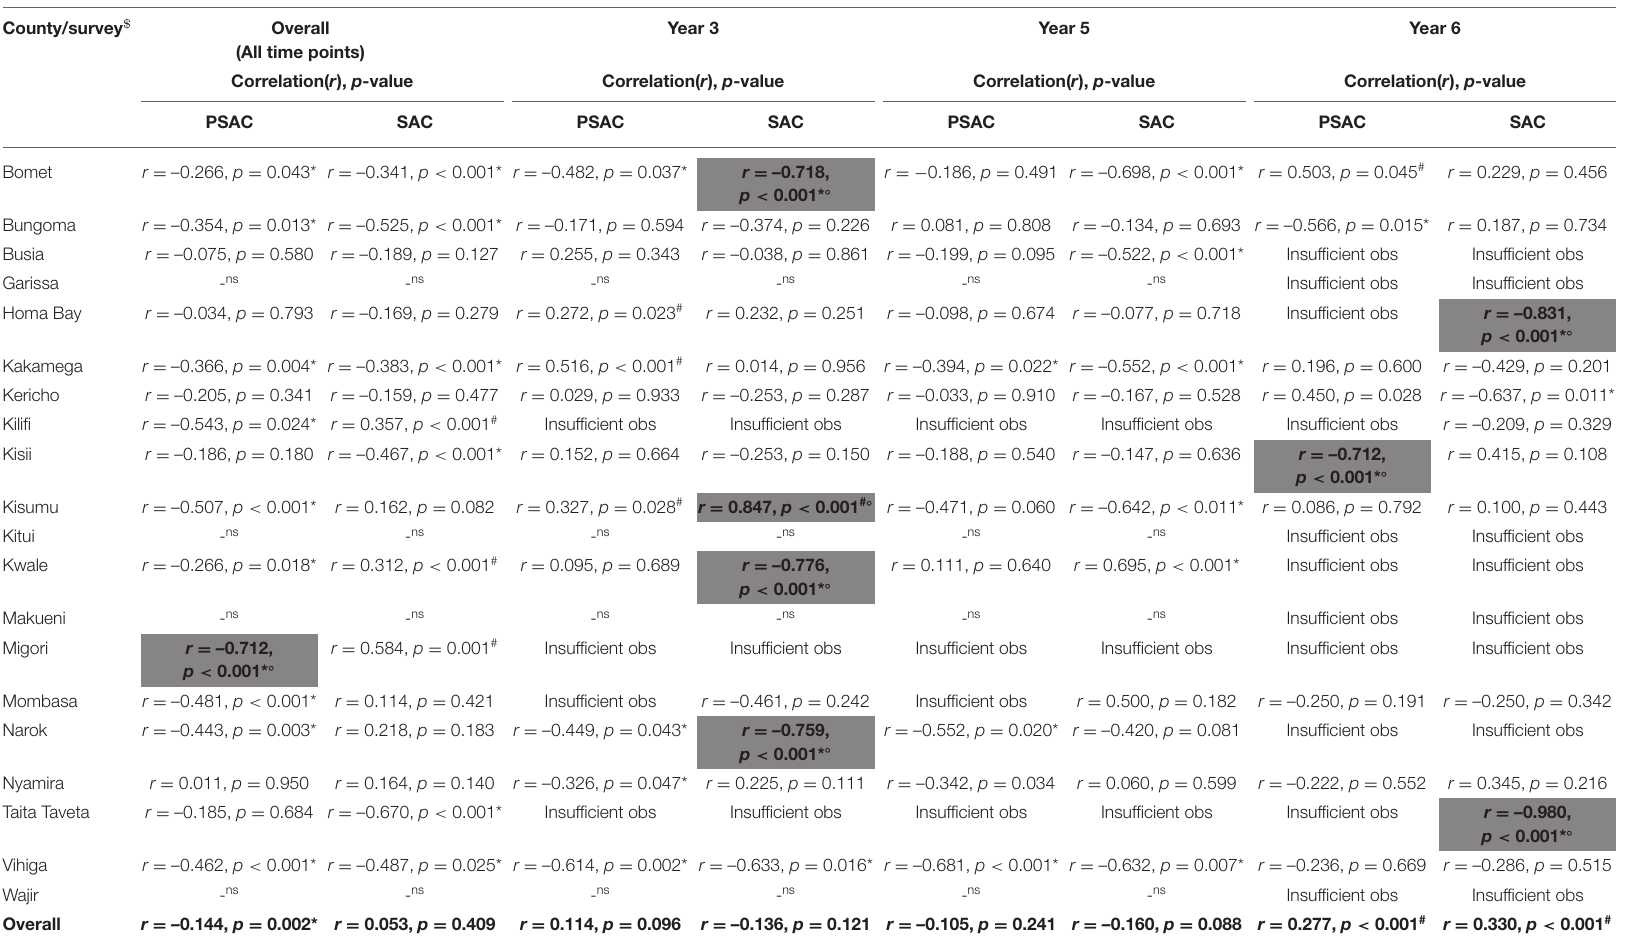
TABLE 6 | Overall and survey time point correlations between pre-treatment undifferentiated STH prevalence of infection and previous year treatment coverage by county among pre-school (PSAC) and school (SAC) aged group of children in